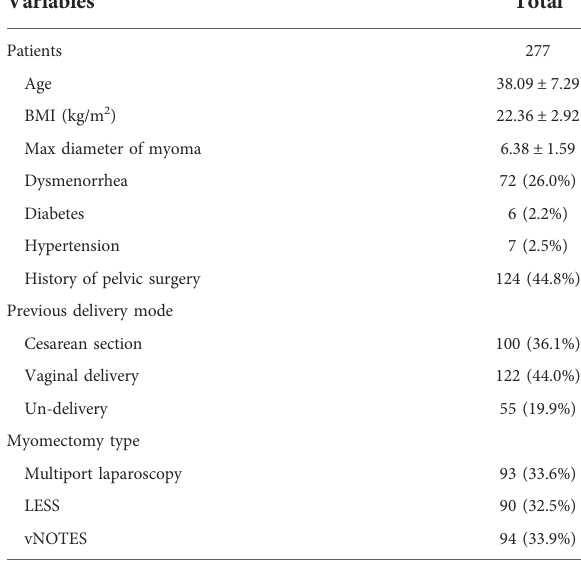
TABLE 1 Description of the patients ’ demographic characteristics and operation